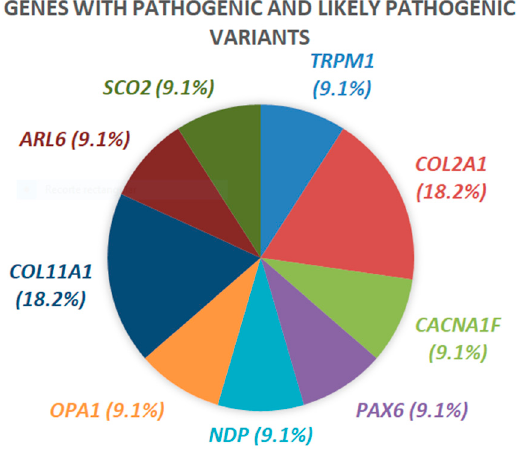
Figure 5. Representation of genes with pathogenic and likely pathogenic variants and their proportion.